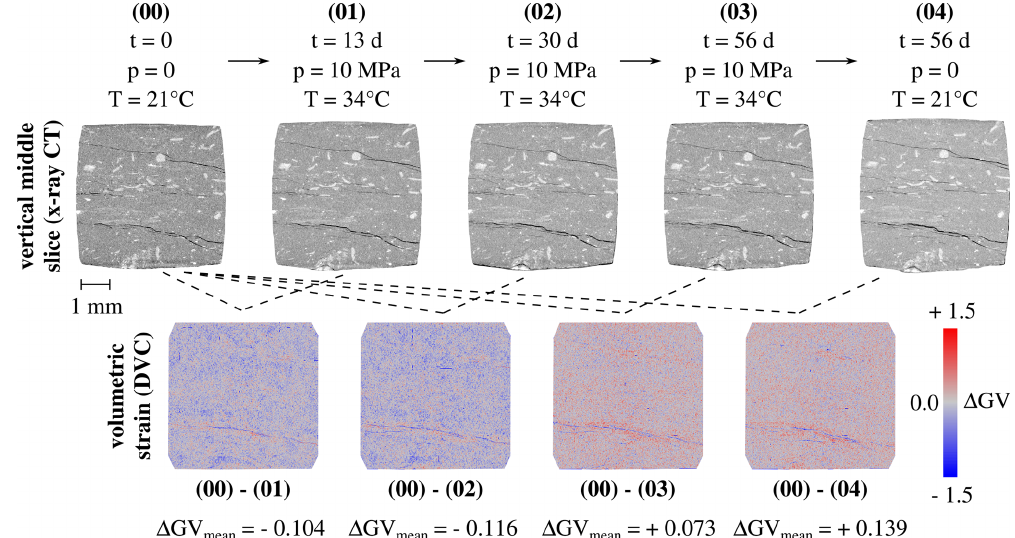
Figure 8. Fields of the grey value changes in the caprock material in time after removing the changes due to volumetric strain; the chosen colour bar represents density (in terms of GV) increase (red) or decrease